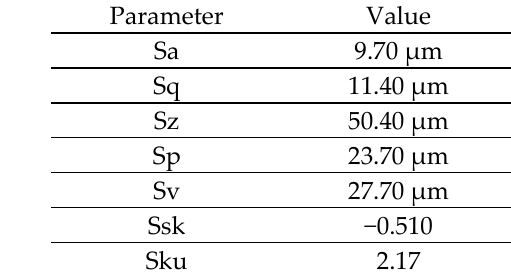
Figure 10. Roughness measurement results for the ABS material: ( a ) before testing; ( b ) after testing.